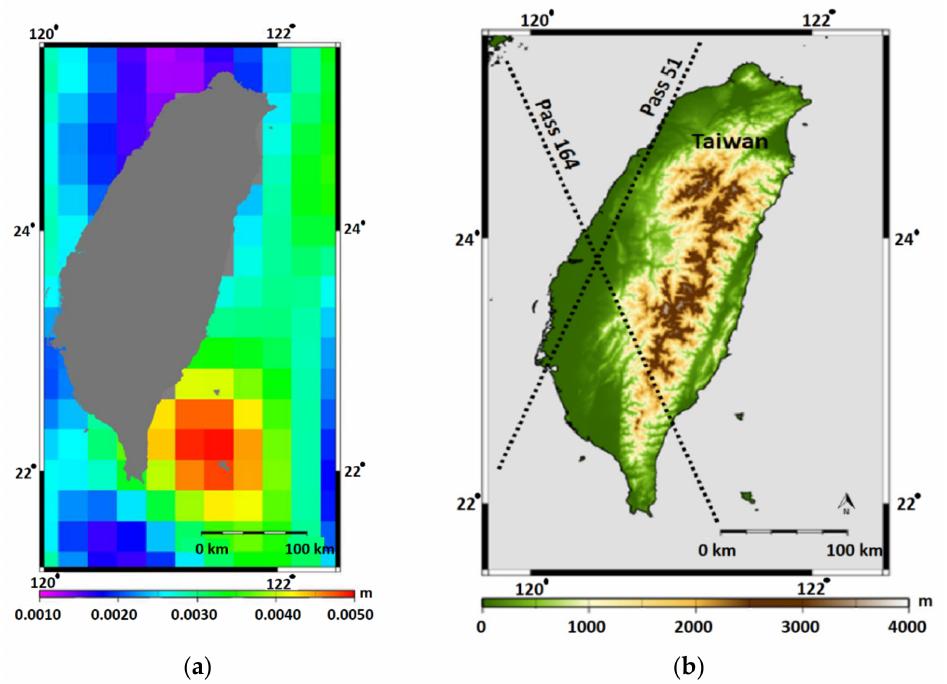
Figure 3. The sea level rise (SLR) trend around Taiwan over a 20-year period ( a ) and Digital Elevation Model (DEM) of Taiwan along with satellite altimetry crossovers ( b